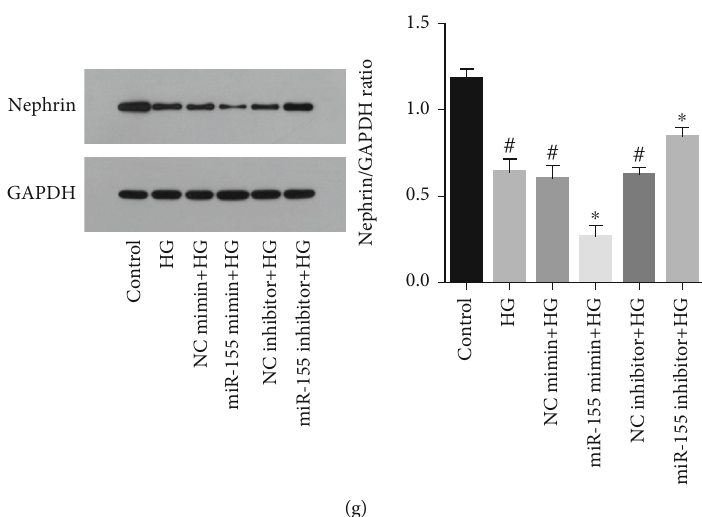
Figure 2: E ff ects of miR-155 on in fl ammation induced by high glucose-triggered podocyte damage. (a) The expression of miR-155 in podocytes transfected with the miR-155 mimic or inhibitor under high glucose condition determined using real-time PCR. (b – e) In fl ammatory cytokines (MCP-1, TNF- α , IL-1 β , and IL-6) secretion in podocytes transfected with the miR-155 mimic or inhibitor under high glucose conditions was assessed using ELISA. (f, g) Nephrin expression in podocytes transfected with either a miR-155 mimic or inhibitor was evaluated using real-time PCR and Western blotting analysis. # Compared with control group, P < 0 : 05 ; ∗ Compared with HG (high glucose) group, P < 0 : 05